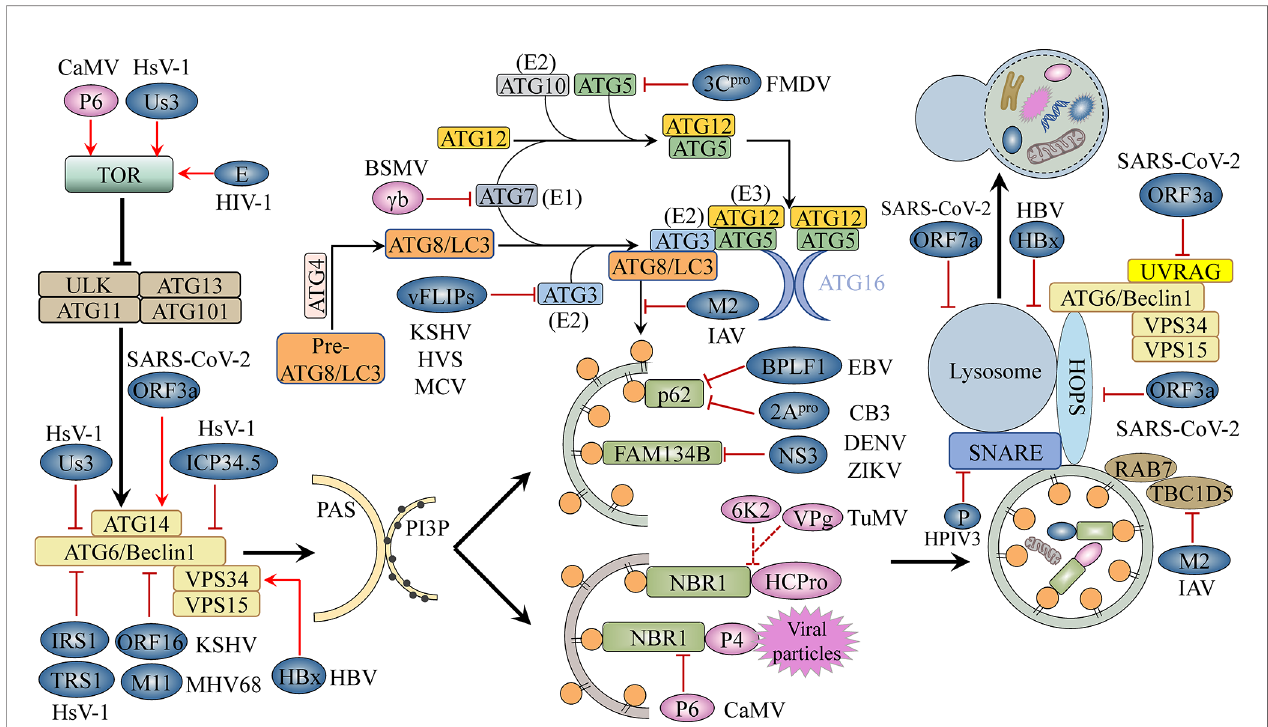
FIGURE 1 | The autophagy machinery and its inhibition by viruses. The ATG1/ULK1 complex, the ATG6/Beclin1-PI3K/VPS34 complex, and the ATG12-ATG5-ATG16 and ATG8-PE conjugation systems, among others, are involved in key steps of the autophagy pathway, including initiation, elongation, completion, and fusion. Viral proteins block cellular autophagy and promote virus development by activating TOR, a conserved Ser/Thr kinase; interacting with autophagy-related proteins, thereby inhibiting or promoting their activity; targeting selective autophagy processes; and interfering with autophagosome – lysosome fusion or lysosomal acidi fi cation. Blue-grey ovals represent animal viral proteins. Plant viral proteins are shown in pink. TOR, target of rapamycin; PAS, pre-autophagosomal structure; PI3P, phosphatidylinositol-3- phosphate; E1/2/3, E1/2/3-like